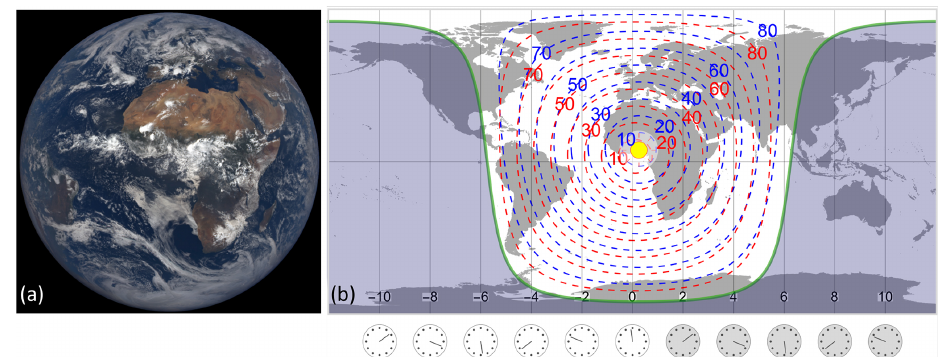
Figure 1. (a) Example of the EPIC field of view (FOV): EPIC Earth image at 11:40:31UTC on 4 September 2015. Image source: NASA EPIC Team, accessed via https://epic.gsfc.nasa.gov (last access: 1 October 2022). (b) Viewing and illumination angles are taken from FOV on the left. The subsolar point is marked on the map with a yellow dot. The area shaded with midnight blue is in the dark, i.e., without direct sunlight, while the unshaded area is the sunlit hemisphere, with sunrise on the left (west of subsolar point) and sunset on the right (east of subsolar point). Contours of solar zenith angles (SZAs, blue dashed lines) and viewing zenith angles (VZAs, red dashed lines), going from 10 to 80 ◦ with a step of 10 ◦ , are shown in the sunlit area. Note that the SZA ( θ s ) and VZA ( θ v ) of an EPIC IFOV have similar values, and both angles increase as the IFOV moves from the center towards the edge of the sunlit disk.